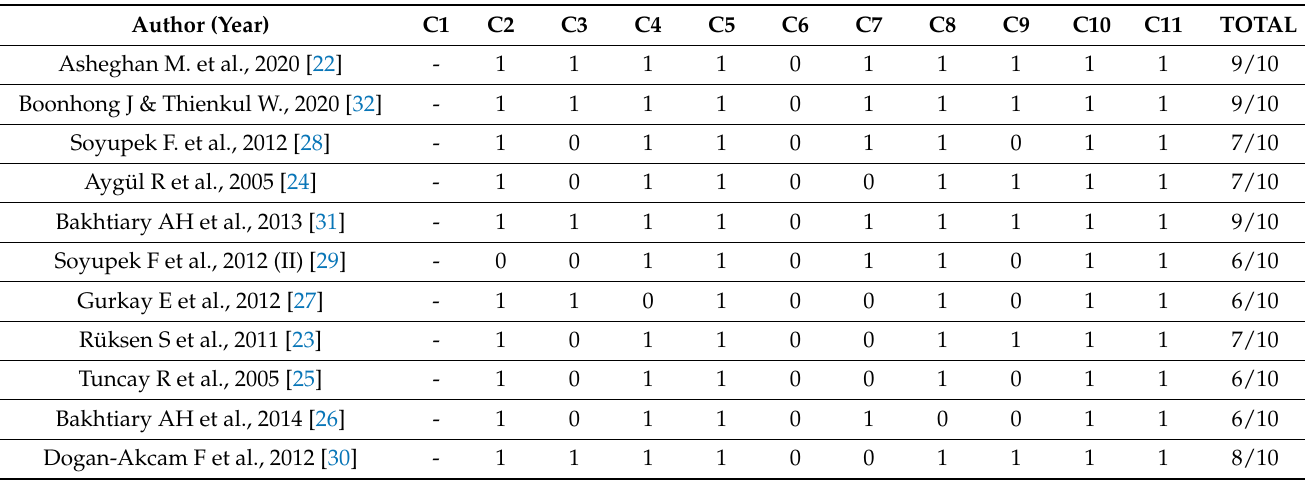
Table 3. Studies methodological quality (PEDro).